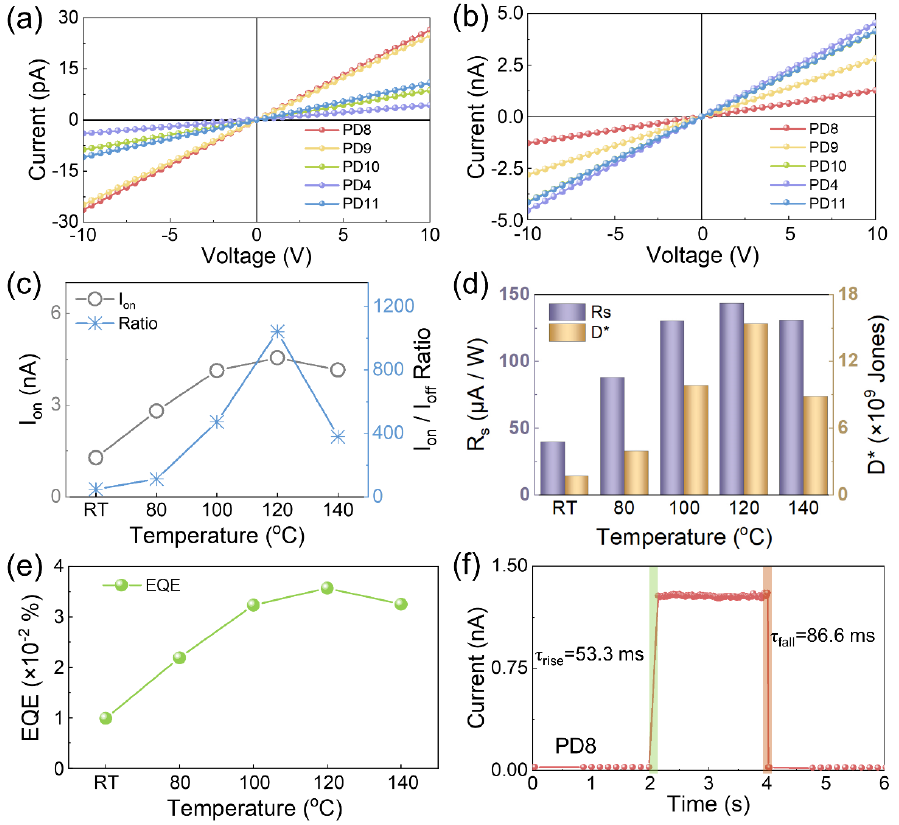
Figure 6. The photoelectric performance of the photodetectors fabricated at various annealing temperatures. I-V characteristics of the devices ( a ) in the dark and ( b ) irradiated under 500 nm UV light (1.97 mW cm − 2 ). ( c ) The plots of I on and I on /I off ratio for each device. ( d ) R s , D*, and ( e ) external quantum efficiency (EQE) of each device fabricated at distinct temperatures. ( f ) The transient response within a single period for the photodetector PD.